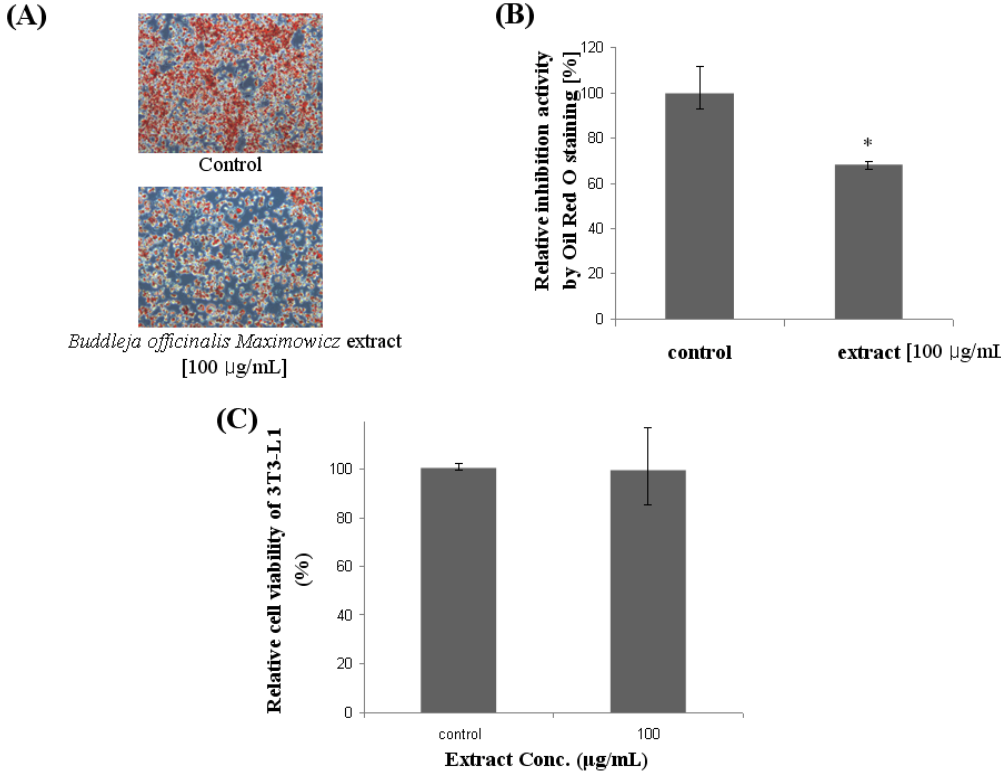
Figure 1. Effect of Buddleja officinalis Maximowicz extract on Oil Red O staining in cultured 3T3-L1 adipocytes. ( A ) Effect of Buddleja officinalis Maximowicz extract on fat droplet formation in 3T3-L1 cells. Fat droplets in preadipocytes were differentiated with 100 μ g/mL of Buddleja officinalis Maximowicz extract treatment for 10 days and it was stained with Oil Red O dye and examined using a light microscope; ( B ) Relative inhibition by quantification method of Oil Red O staining. Values are expressed as mean ± standard deviation of at least three independent from that of the control treatment. Values are means ± SE (n = 3), ** p < 0.001; ( C ) Cell viability by MTT